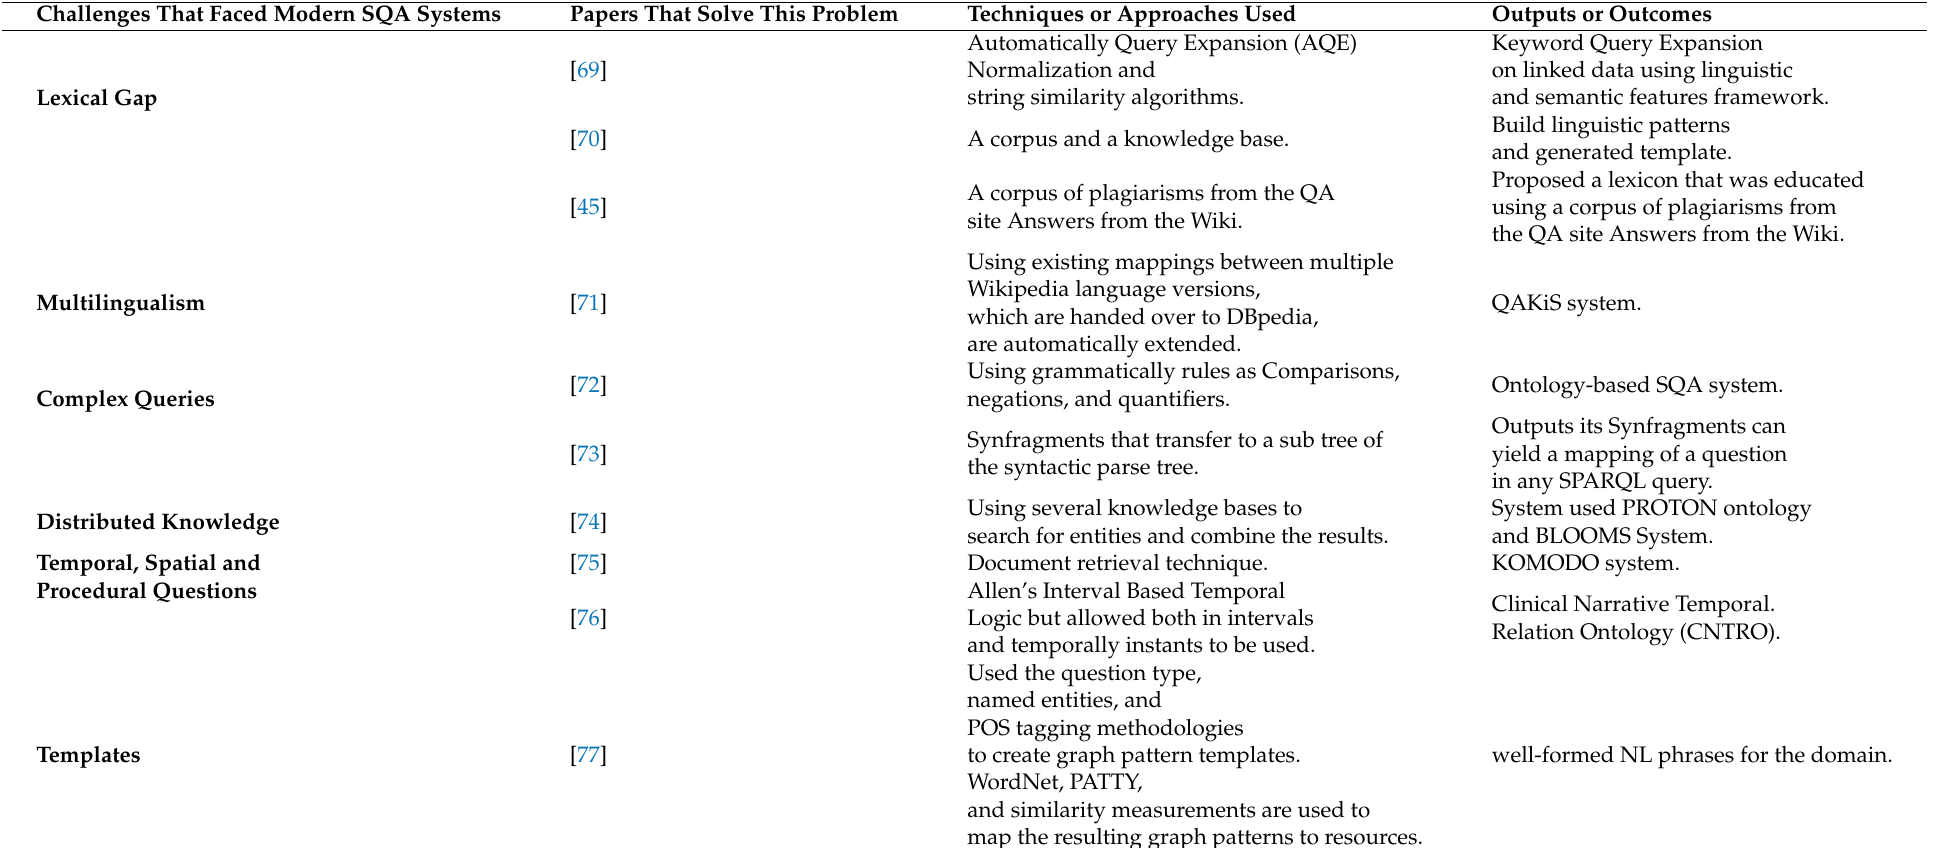
Table 4. Challenges of